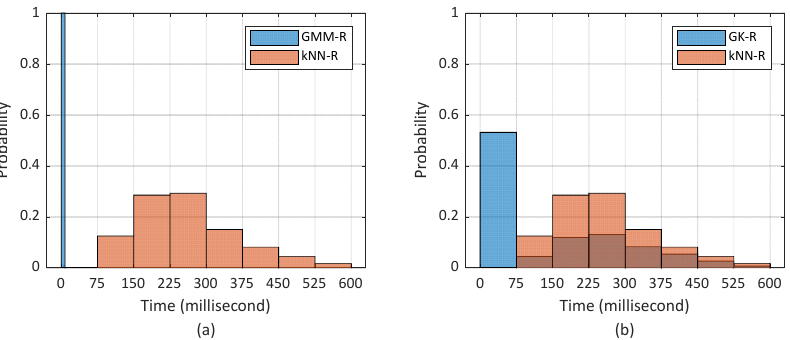
Figure 7. The average time cost of recognizing one movement by each classifier. Each histogram is normalized so that the summation of the height of the bins is one. ( a ) Comparison of the time cost of GMM-R and kNN-R. ( b ) Comparison of the time cost of GK-R and kNN-R.